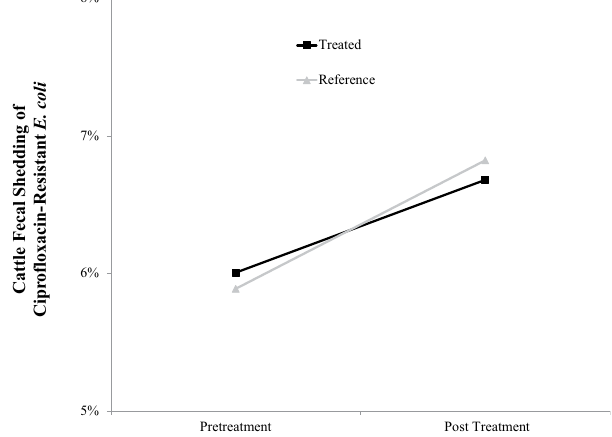
Figure 4. Probability of detecting ciprofloxacin-resistant Escherichia coli in cattle feces on starling controlled (treated) and non-controlled (reference) feedlots before and after DRC-1339 applications within Texas, Colorado, Kansas, Missouri and Iowa between December 2012 and April 2013.